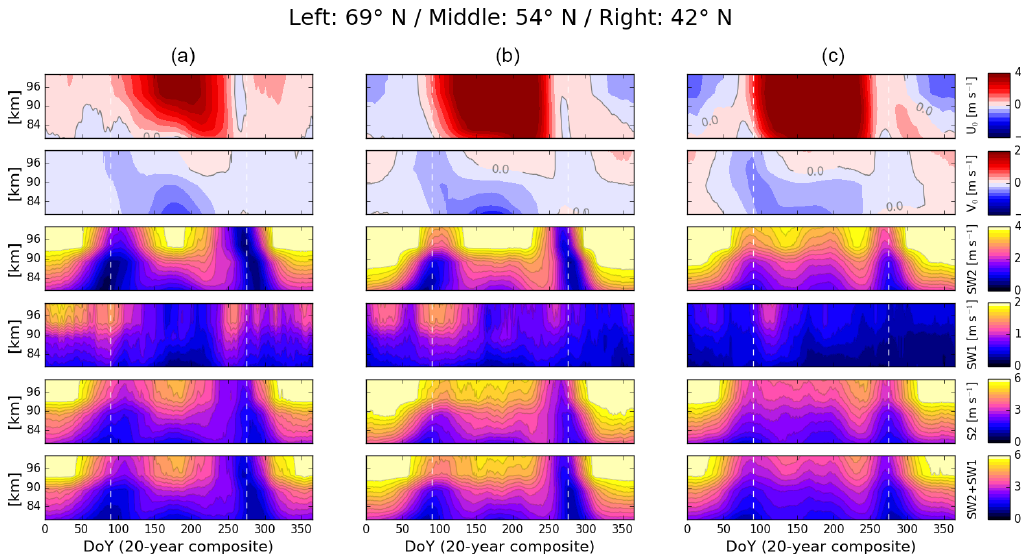
Figure 3. HAMMONIA composites of the simulated mean zonal ( U 0 ) and meridional winds ( V 0 ), migrating semidiurnal (SW2), non- migrating westward-propagating wave number 1 semidiurnal (SW1), and total semidiurnal (S2) solar tides, and SW2 + SW1, over (column a ) Andenes, (column b ) Juliusruh and (column c ) Tavistock. The vertical white dashed lines indicate DoYs 90 and